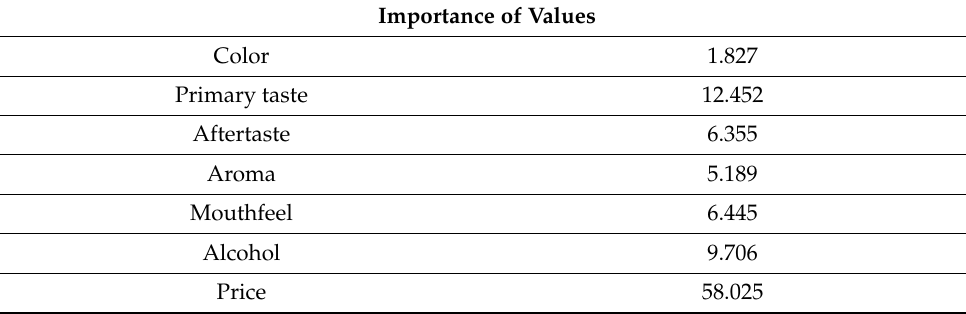
Table 9. Importance of